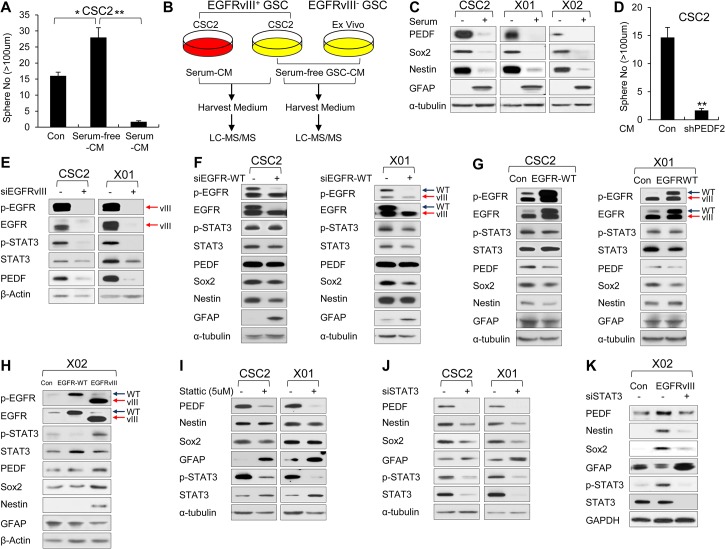
Identification of PEDF as a novel autocrine factor regulated by EGFRvIII through STAT3 signaling.(A) Sphere formation assay of CSC2 cell cultured in control medium (serum-free GSC medium), serum-free GSC-conditioned medium (CM), or serum-CM. Prior to the harvest of CMs, the cells were washed with phosphate buffered saline (PBS) and changed with F12 medium without serum or other supplement for 24 h. The graph represents the average proportion of sphere number. Counted sphere size is greater than 100 μm. All error bars represent mean ± standard error of the mean (SEM) (n = 3). * p < 0.05; ** p < 0.01. (B) Schematic representation of mass spectrometry analysis. CMs from CSC2 cultured in serum-free GSC or serum-cultured medium were respectively harvested after 2 wk. Also, Serum-free GSC CM from CSC2 (EGFRvIII+ GSC) or Ex Vivo (EGFRvIII- GSC) were respectively harvested after 2 wk. Prior to the harvest of CMs, the cells were washed with PBS and changed with F12 medium without serum or other supplement for 24 h. All of them were analyzed by liquid chromatography–mass spectrometry–mass spectrometry (LC-MS/MS). (C) IB analysis of PEDF (in medium), Sox2, Nestin, and GFAP in GSCs (CSC2, X01, and X02 cells) incubated in serum-free GSC or serum-cultured medium. α-tubulin was used as a loading control. (D) Sphere formation assay was performed in CSC2 cells incubated in serum-free CSC2-Con or CSC2-shPEDF2 CM. Two CMs respectively obtained from CSC2 cells infected with shPEDF2-expressing lentiviral or control construct, cultured in serum-free GSC medium. The graph represents the average proportion of sphere number. Counted sphere size is greater than 100 μm. All error bars represent mean ± SEM (n = 3). ** p < 0.01. (E) IB analysis of p-EGFR, EGFR, p-STAT3, STAT3, and PEDF (in medium) in GSCs (CSC2 and X01cells) transfected with EGFRvIII siRNA or its control. β-actin was used as a loading control. (F) IB analysis of p-EGFR, EGFR, p-STAT3, STAT3, PEDF (in medium), Sox2, Nestin, and GFAP in GSCs (CSC2 and X01) transfected with siEGFR-WT or siControl. α-tubulin was used as a loading control. (G) IB analysis of p-EGFR, EGFR, p-STAT3, STAT3, PEDF (in medium), Sox2, Nestin, and GFAP in GSCs (CSC2 and X01) infected with EGFR WT-expressing lentiviral or control construct. α-tubulin was used as a loading control. (H) IB analysis of p-EGFR, EGFR, p-STAT3, STAT3, PEDF (in medium), Sox2, Nestin, and GFAP in X02 cells infected with EGFR-WT, EGFRvIII-expressing lentiviral or their control construct. β-actin was used as a loading control. (I) IB analysis of PEDF (in medium), Nestin, Sox2, GFAP, p-STAT3, and STAT3 in CSC2 and X01 cells treated with a small-molecule inhibitor of STAT3 (Stattic, 5 uM) or vehicle for 6 h. α-tubulin was used as a loading control. (J) IB analysis of PEDF (in medium), Nestin, Sox2, GFAP, p-STAT3, and STAT3 in CSC2 and X01 cells transfected with siSTAT3 or its control. α-tubulin was used as a loading control. (K) IB analysis of PEDF (in medium), Nestin, Sox2, GFAP, p-STAT3, and STAT3 in X02 cells infected with EGFRvIII-expressing lentiviral or their control construct. Also, these cells were transfected with siSTAT3 or its control. GAPDH was used as a loading control.